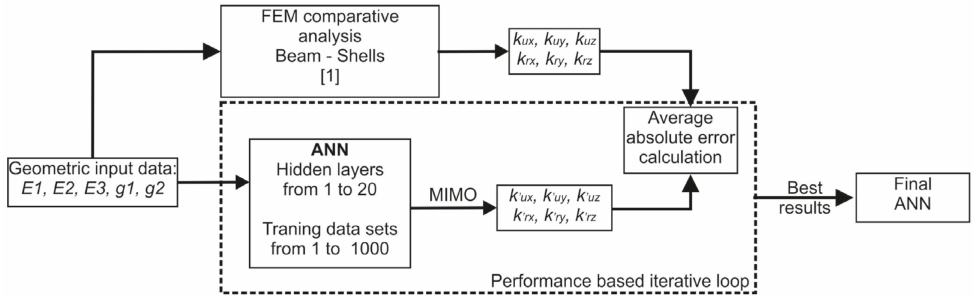
Figure 7. Block diagram of the applied methodology for the selection of the best